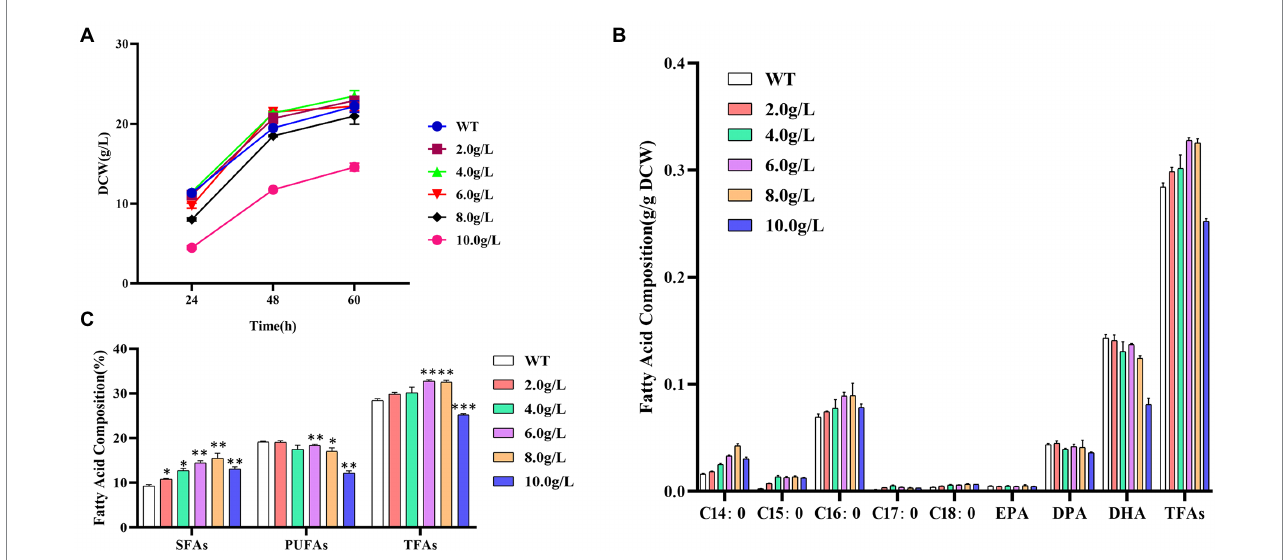
FIGURE 1 Effects of different concentrations of propanol on Schizochytrium ATCC 20888. (A) Growth curves; (B) Fatty acid composition; (C) Composition of saturated fatty acids (SFAs), polyunsaturated fatty acids (PUFAs) and total fatty acids (TFAs). * p -value <0.1, ** p -value <0.05, *** p -value